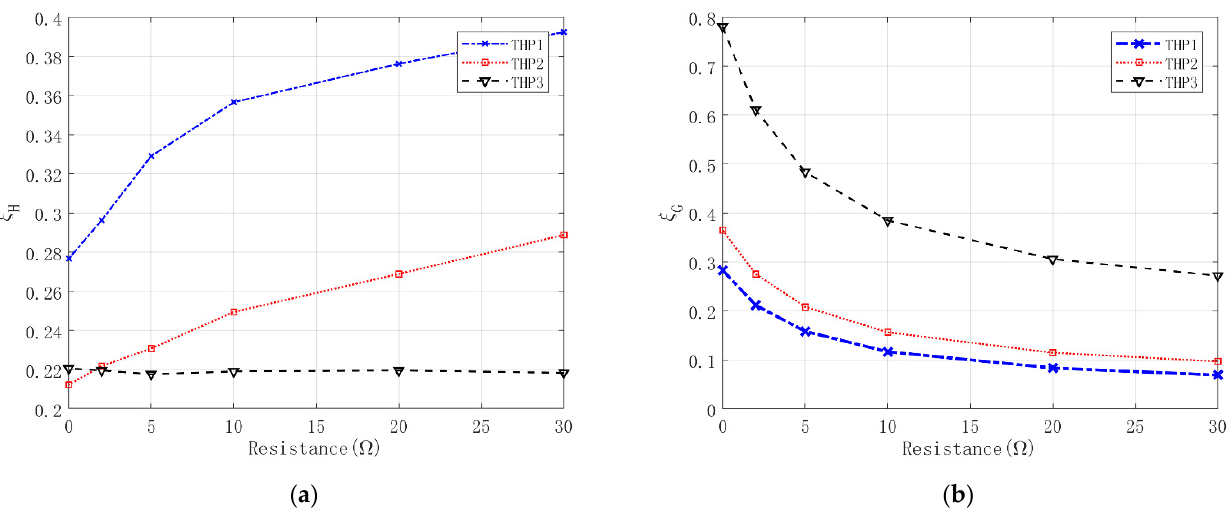
Figure 14. The damping of the tuned heave plate system at the resonant period with different LRs . ( a ) Damping ratio of each THPEH contributed by hydrodynamic force; ( b ) Damping ratio at the resonant period of each THPEH contributed by the motor.